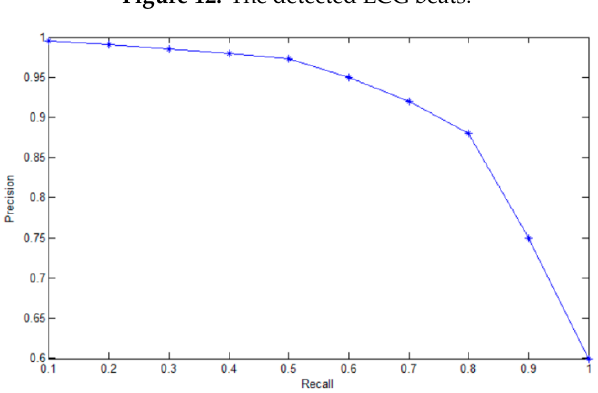
Figure 12. The detected ECG beats.